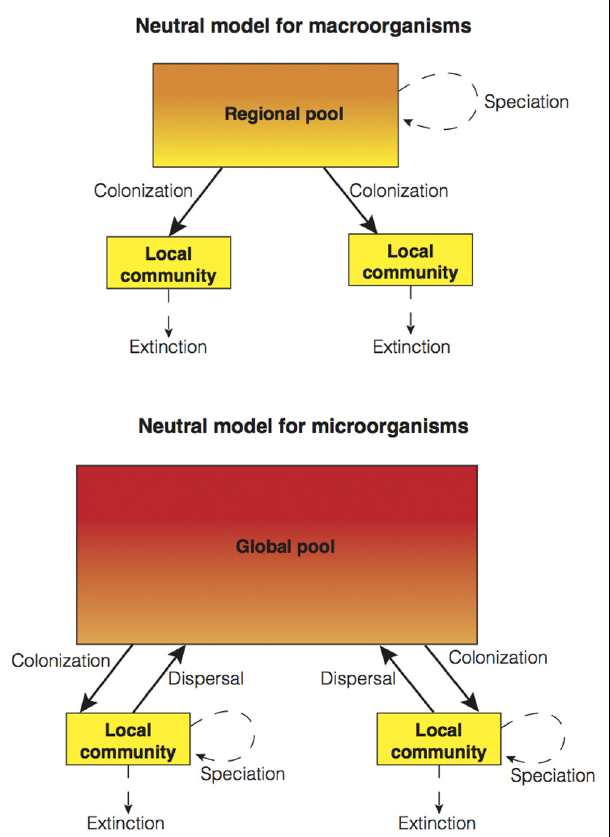
FIGURE 3 |A schematic representation of two neutral models: Hubbell’s original two-level spatially implicit model (Hubbell, 2001) for macroorganisms (above), and a suggested model for microorganisms (below). Both models are based on the same mechanistic processes operating at different scales.The main differences are that, in the neutral model for microorganisms, global scale dynamics become more important with the incorporation of long-distance dispersal to the global pool due to high dispersibility, and high speciation introduced by placing this process at the local scale. As in Figure 1 , the demarcation of discrete spatial scales is